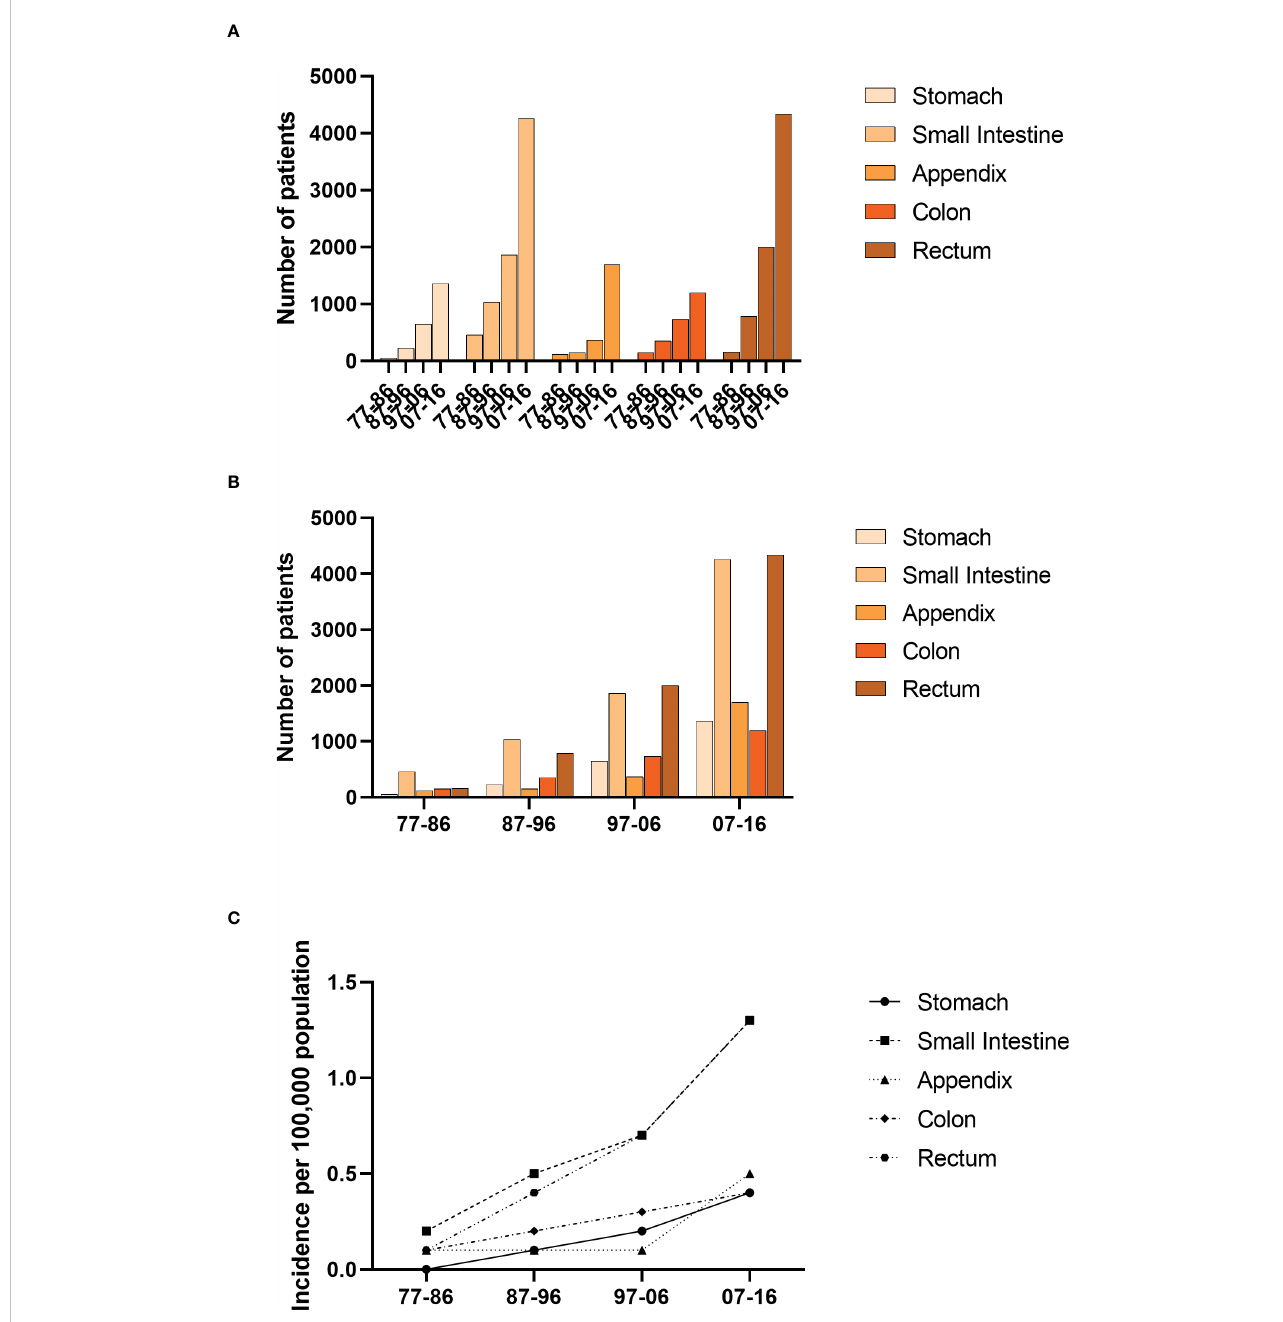
FIGURE 3 Incidence of Patients diagnosed with GI-NETs at the original nine SEER sites between 1977 and 2016. The number (A, B) and incidence (C) of GI-Nets cases are shown by site group (stomach, small intestine, appendix, colon, rectum) and four-time